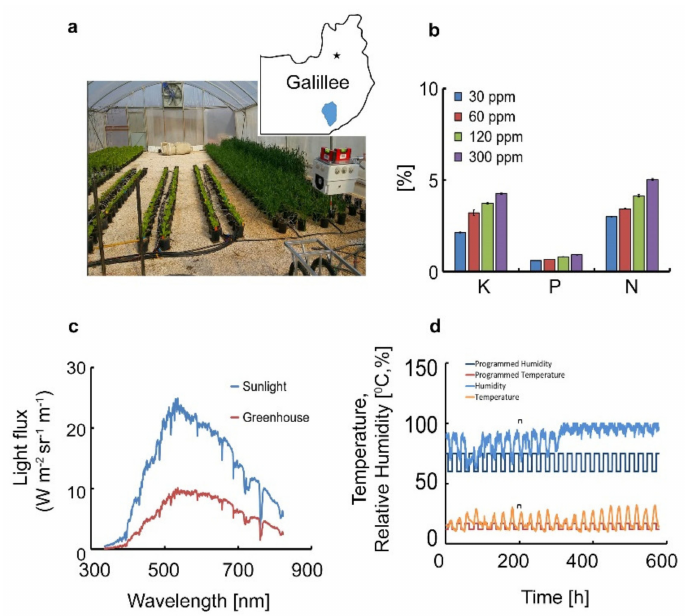
Figure 2. Experimental conditions of the fertilization gradient experiment on L. sativa . ( a ) The greenhouse L. sativa setup and location (Panel A subset). ( b ) Macro-nutrients composition of the leaves where K:P:N stands for Potassium: Phosphate:Nitrogen, respectively. Color code is the same throughout the manuscript for the lettuce dataset: blue, red, green and purple refer to 30, 60, 120 and 300 ppm total nitrogen, respectively. ( c ) Dual spectra comparison between the interior and exterior of the greenhouse. ( d ) Humidity and temperature by season and experiment (blue and brown lines,